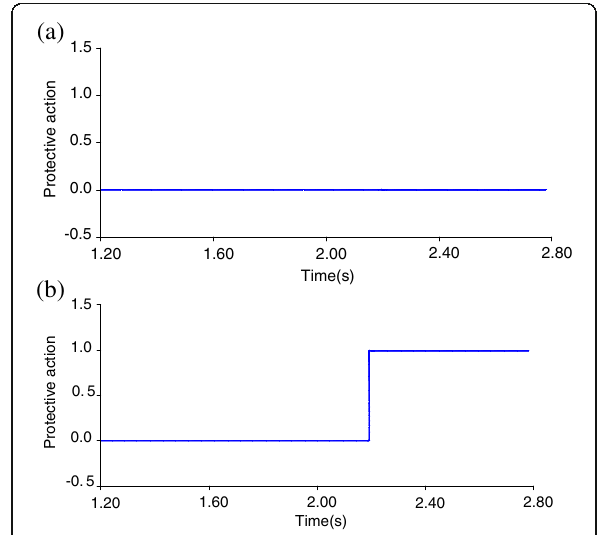
Fig. 9 the improvement low voltage motion curve of the PMSG Fig. 10 a Common protective action b Improved protective